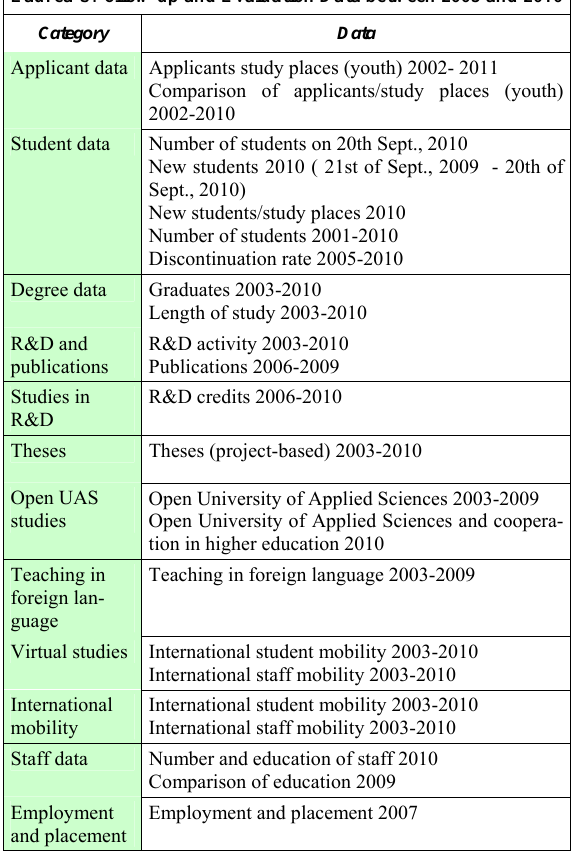
TABLE I. F OLLOW - UP AND E VALUATION D ATA Laurea’s Follow-up and Evaluation Data between 2003 and